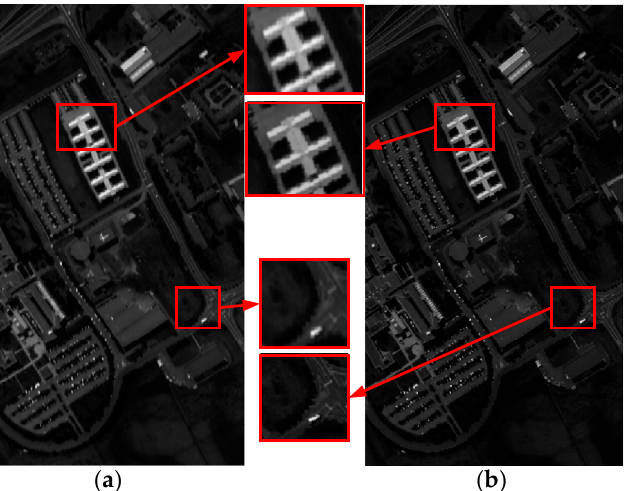
Figure 4. Comparison of results with and without DANCE: ( a ) reconstructed image (with GF); ( b ) the un-preprocessed image (without GF). un-preprocessed image (without GF).